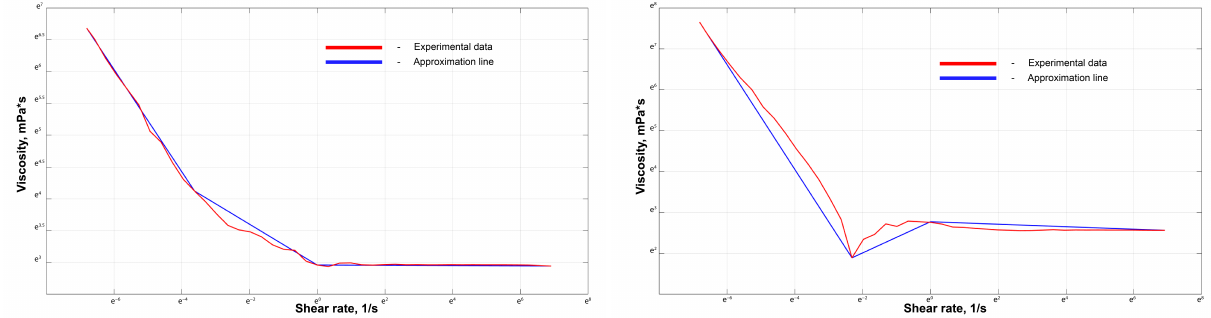
Figure 8. Experimental data of Onyx (cid:114) ( left ) and Squid (cid:114) ( right ) viscosity dependence on shear rate and the piecewise linear approximation that was used for numerical simulations (logarithmic